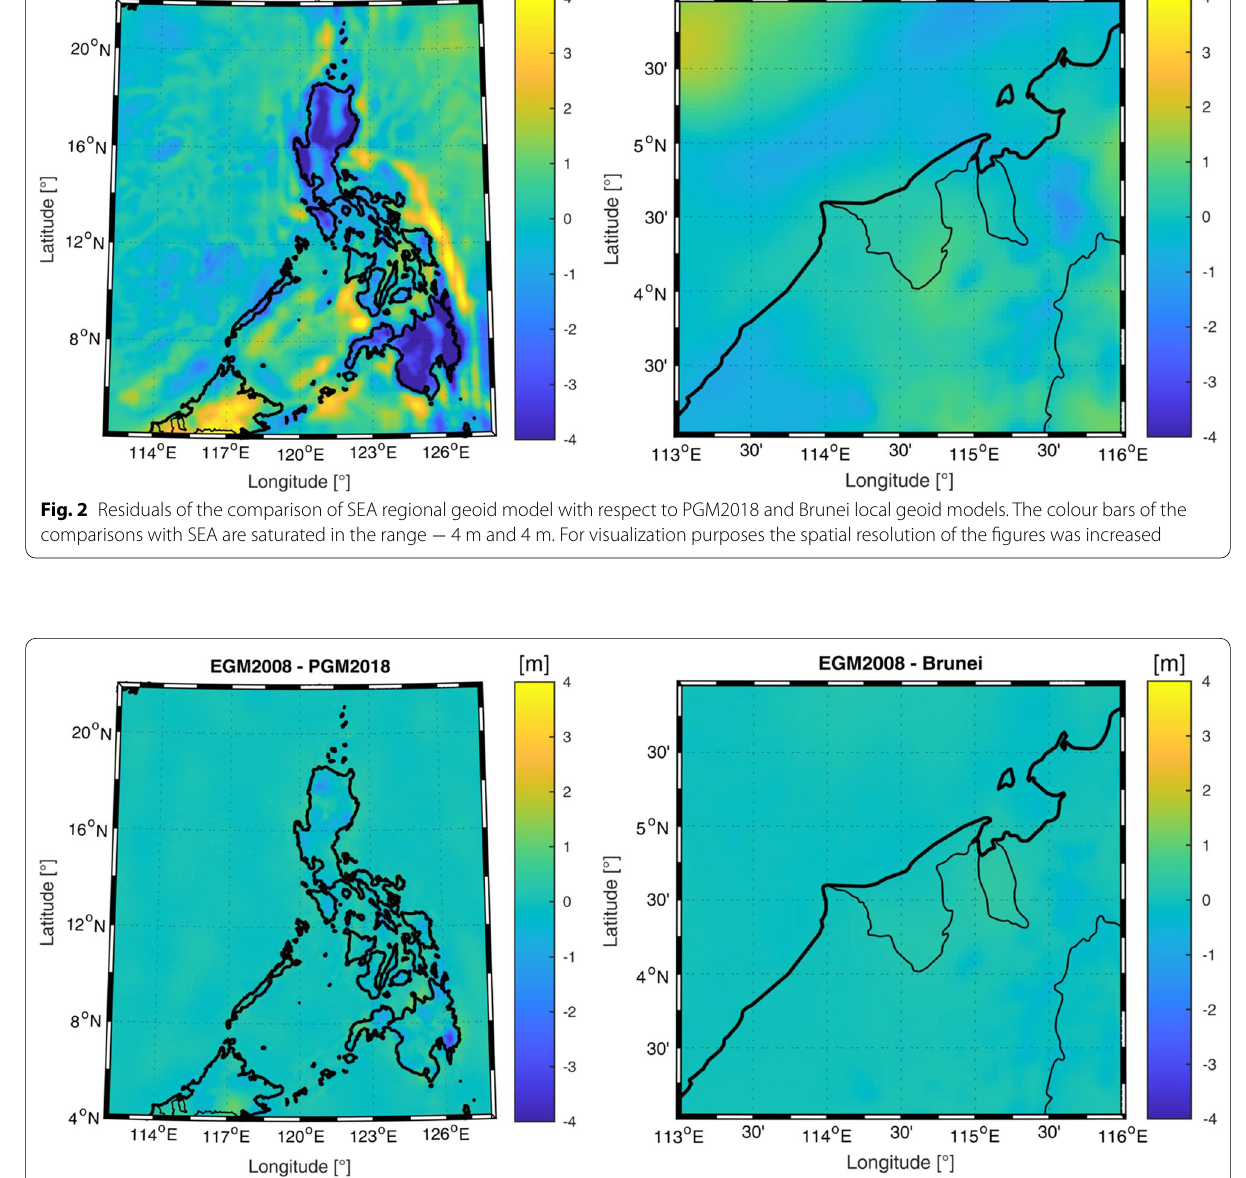
Fig. 3 Residuals of the comparison of EGM2008 global geoid model with respect to PGM2018 and Brunei local geoid models. For visualization purposes, colour bars and spatial resolution of the figures were made consistent with Fig.